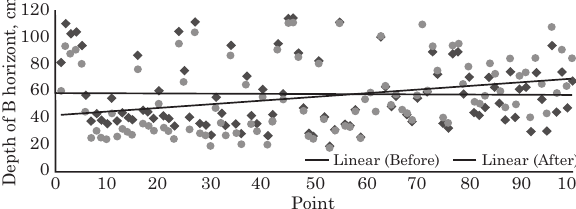
Figure 8. Depth variation of the top of the B horizon before and after land leveling. Solid line before leveling and dotted line after